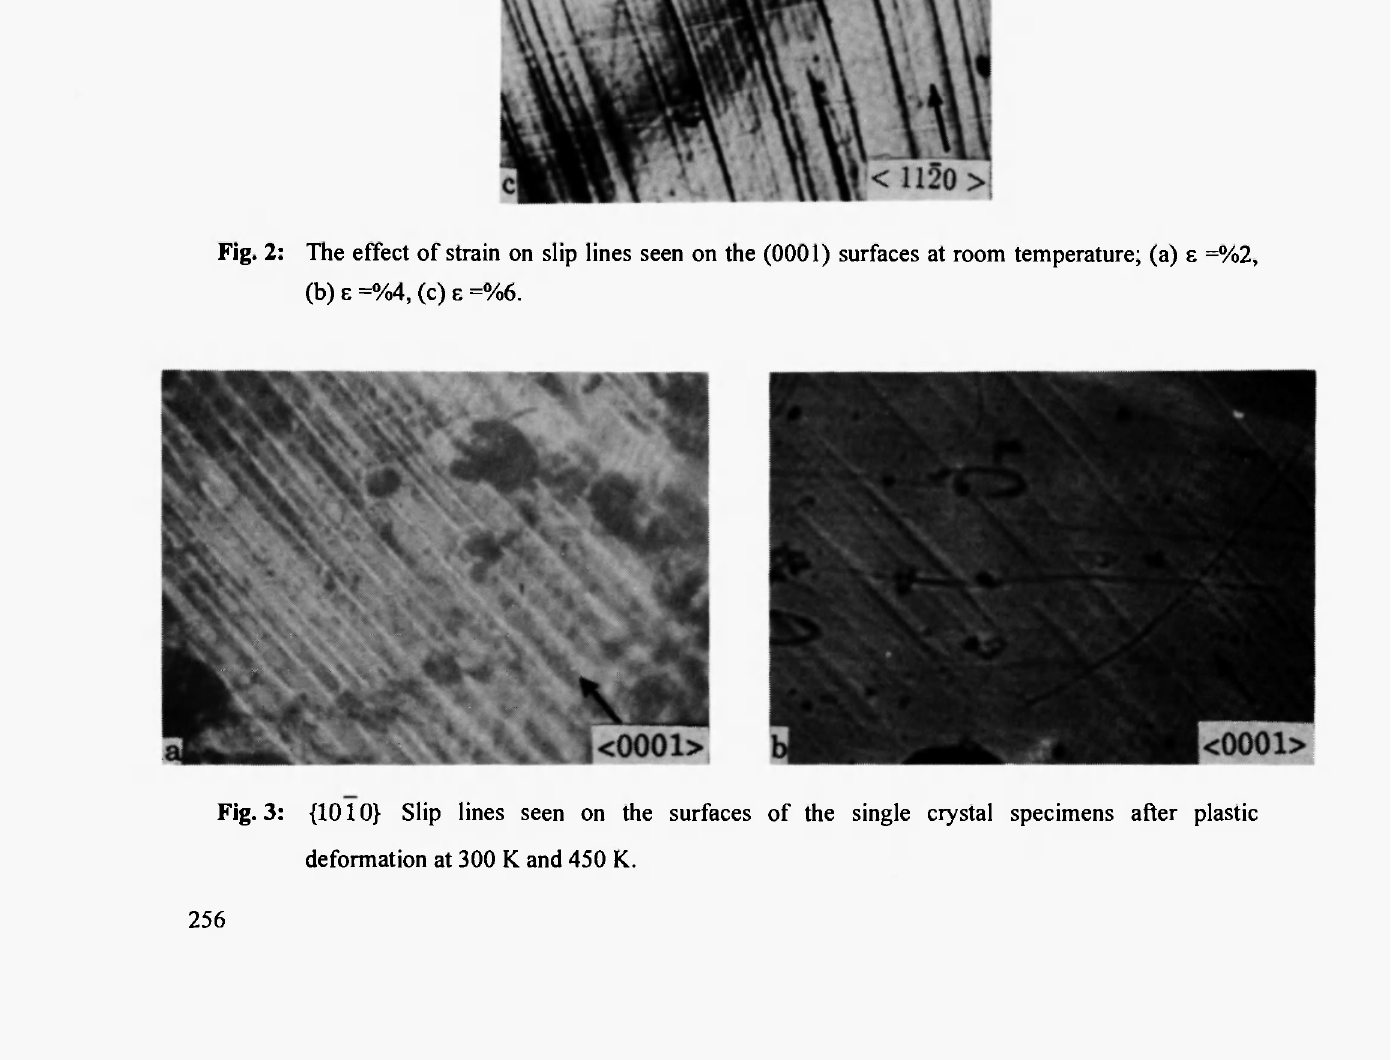
Fig. 2: The effect of strain on slip lines seen on the (0001) surfaces at room temperature; (a) ε =%2, (b) ε =%4, (c) ε =%6.